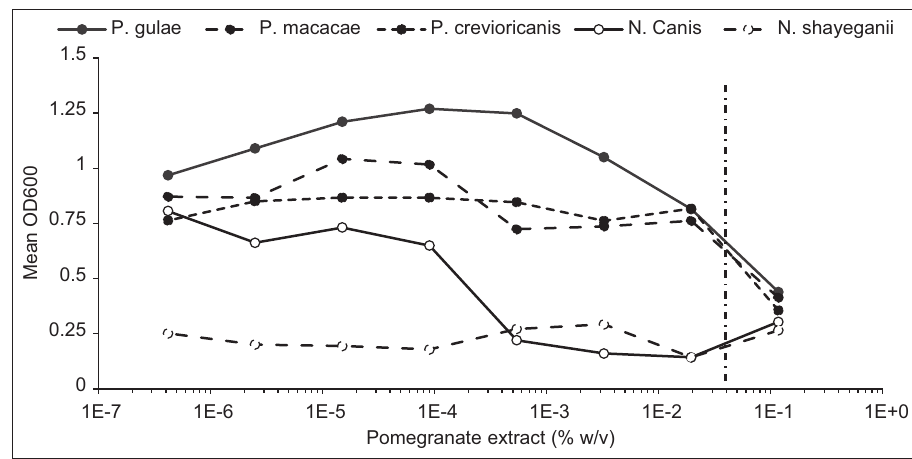
Figure-2: Growth inhibition of the bacterial strains tested by different concentrations of the pomegranate extract. Data are expressed as the mean optical density at the different concentrations of the extract tested. The vertical dotted line represents the concentration of the extract equivalent to what is found in Aquadent FR3SH and Veggiedent FR3SH.